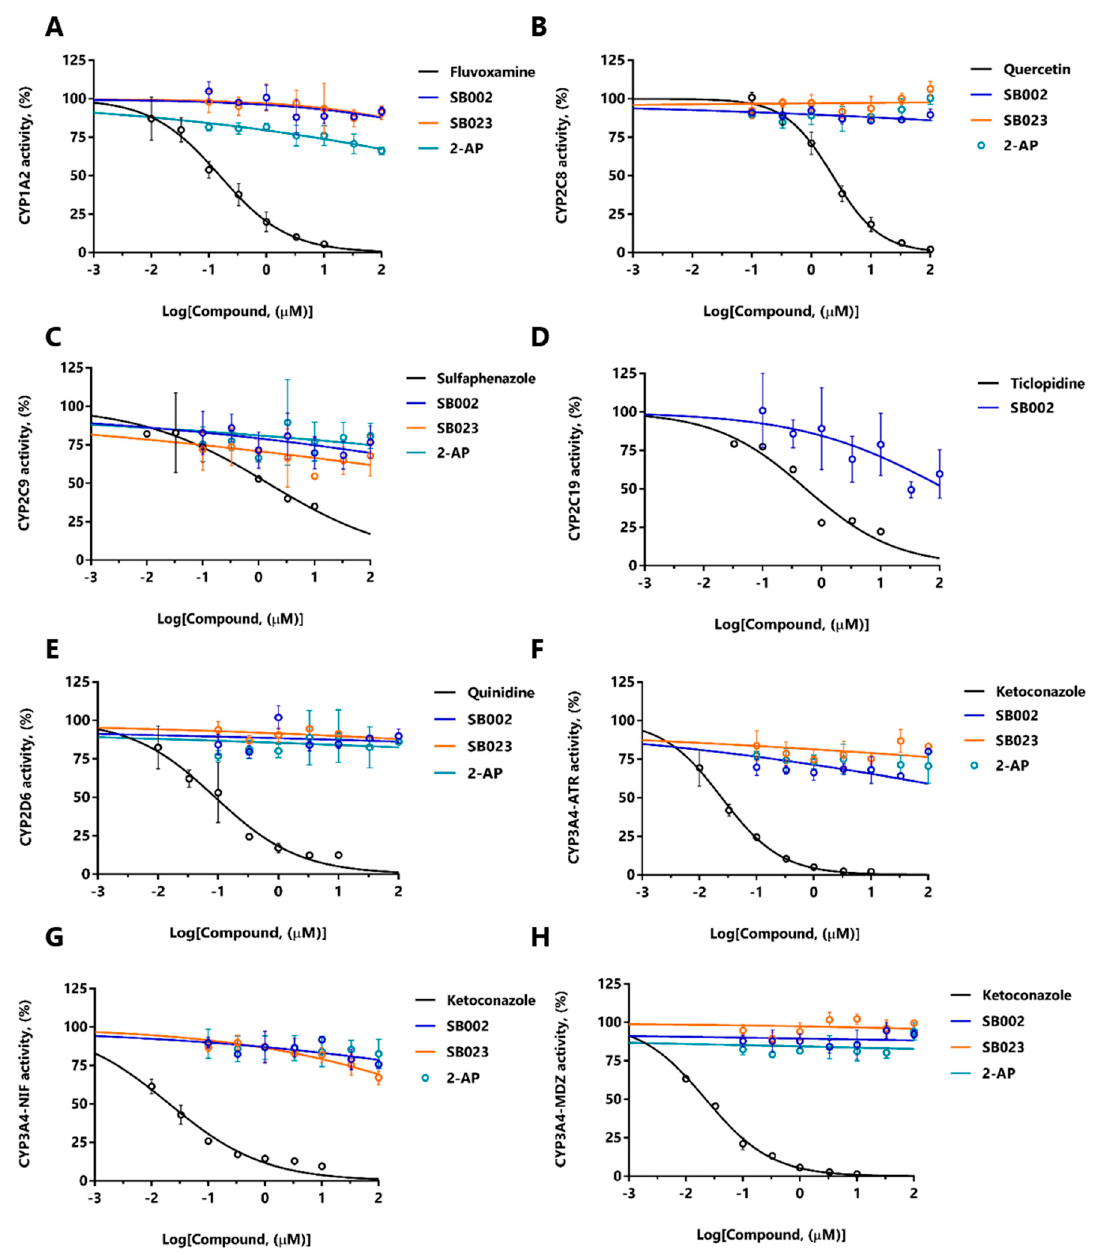
Figure 5. Dose-response inhibition of CYP450 isozymes. SB002 (blue), SB023 (orange), 2-amino-4-chloropyridine (teal), and relevant positive controls (black) were tested for their inhibition of: ( A ) CYP1A2 (positive control: Fluvoxamine), ( B ) CYP2C8 (positive control: Quercetin), ( C ) CYP2C9 (positive control: Sulfaphenazole), ( D ) CYP2C19 (positive control: Ticlopidine), ( E ) CYP2D6 (positive control: Quinidine), ( F ) CYP3A4 binding site 1 (ATR) (positive control: Ketoconazole), ( G ) CYP3A4 binding site 2 (NIF) (positive control: Ketoconazole), and ( H ) CYP3A4 binding site 3 (MDZ) (positive control: Ketoconazole).